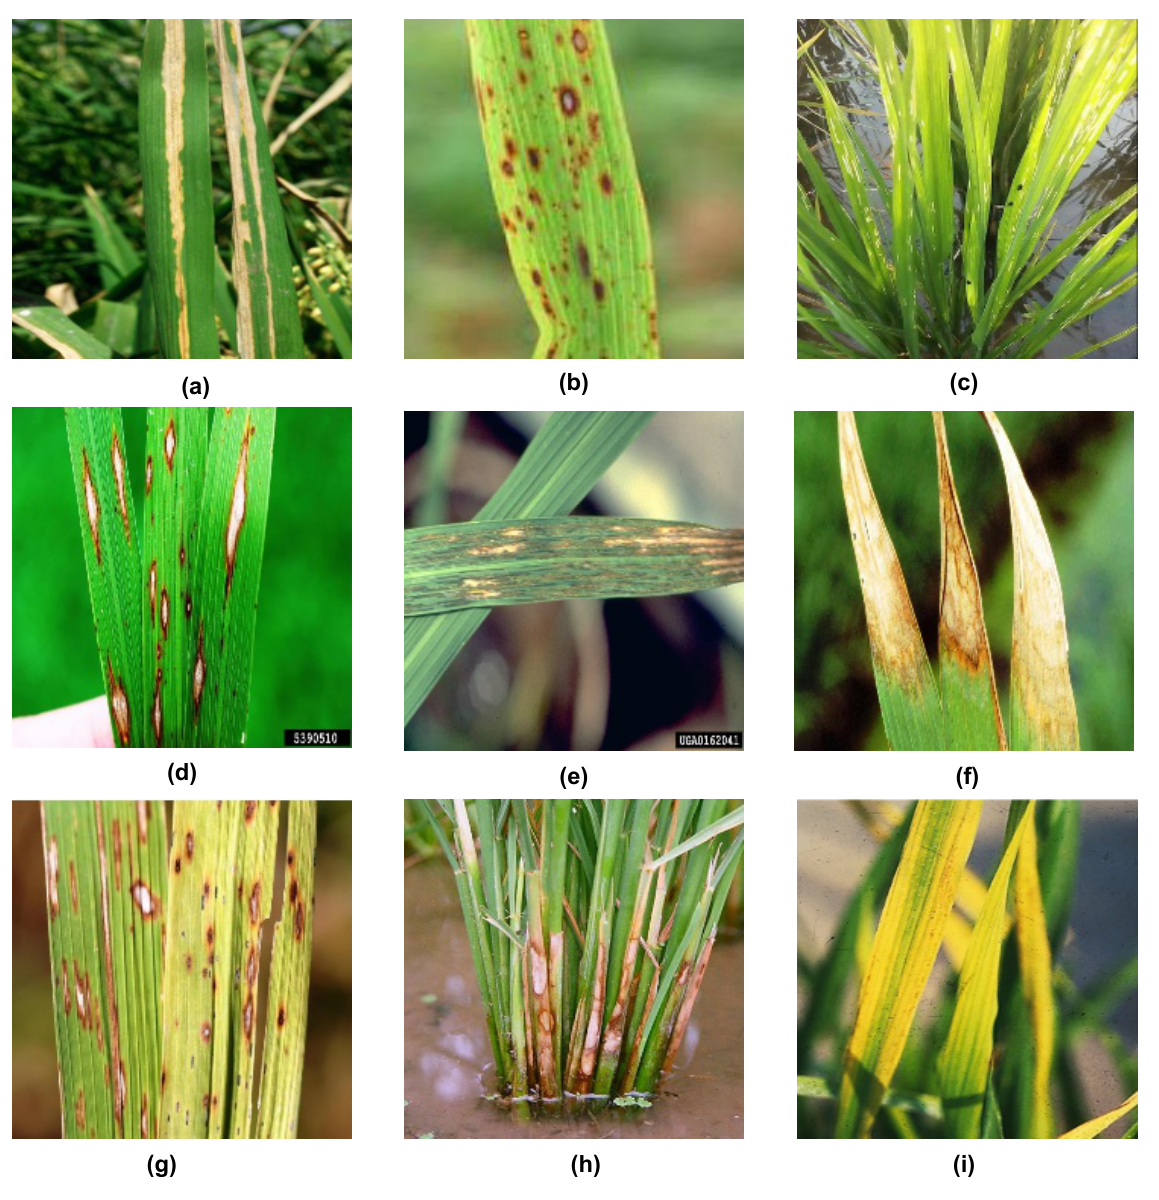
Figure 2. Rice leaf diseases: ( a ) Bacterial Leaf Blight ( b ) Brown spot ( c ) Hispa ( d ) Leaf Blast ( e )